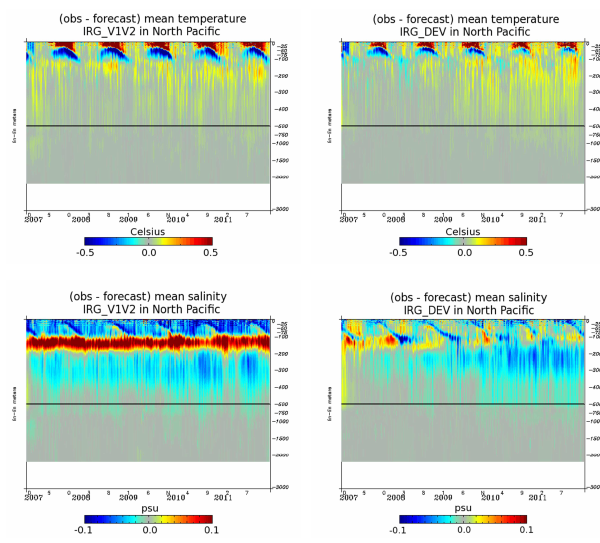
Fig. 20. Assimilation diagnostics with respect to the vertical temperature and salinity profiles over the 2007-2011 period. Mean misfit between observations and model forecast for temperature (top panels) and salinity (low panels), in IRG_V1V2 (left panels) and IRG_DEV (right panels) systems. These scores are averaged over all seven days of the data assimilation window, with a lead time equal to 3.5 days.